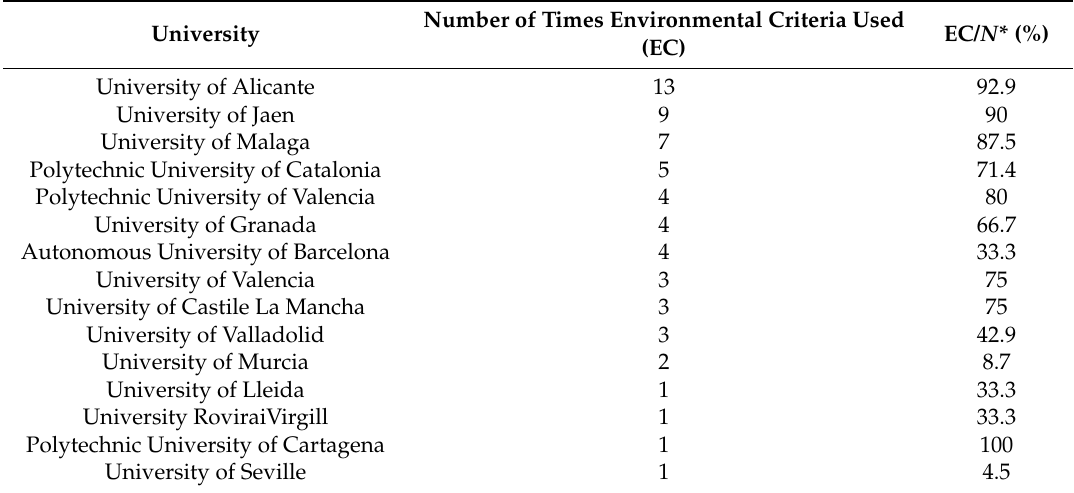
Table 4. Distribution of environmental criteria by universities.